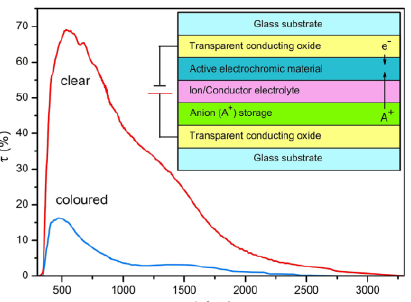
Figure 4. Transmittance modulation of an EC device, between the colored and bleached conditions. The insert reports the cross-section of the multi-layered device measured. Reprinted from “Energy